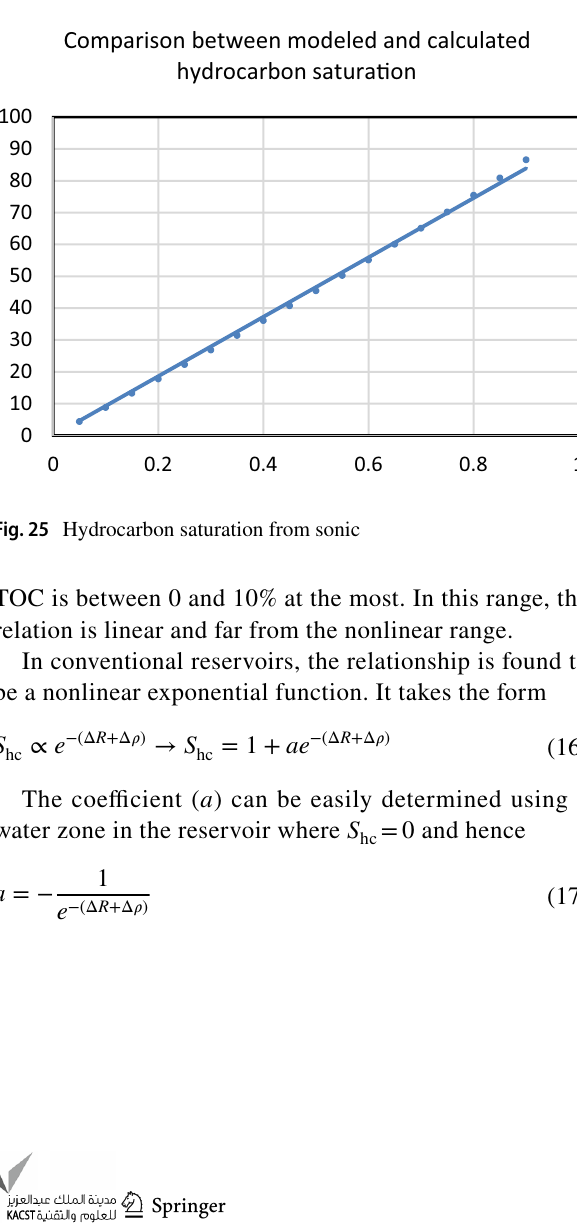
Fig. 26 Hydrocarbon saturation from density